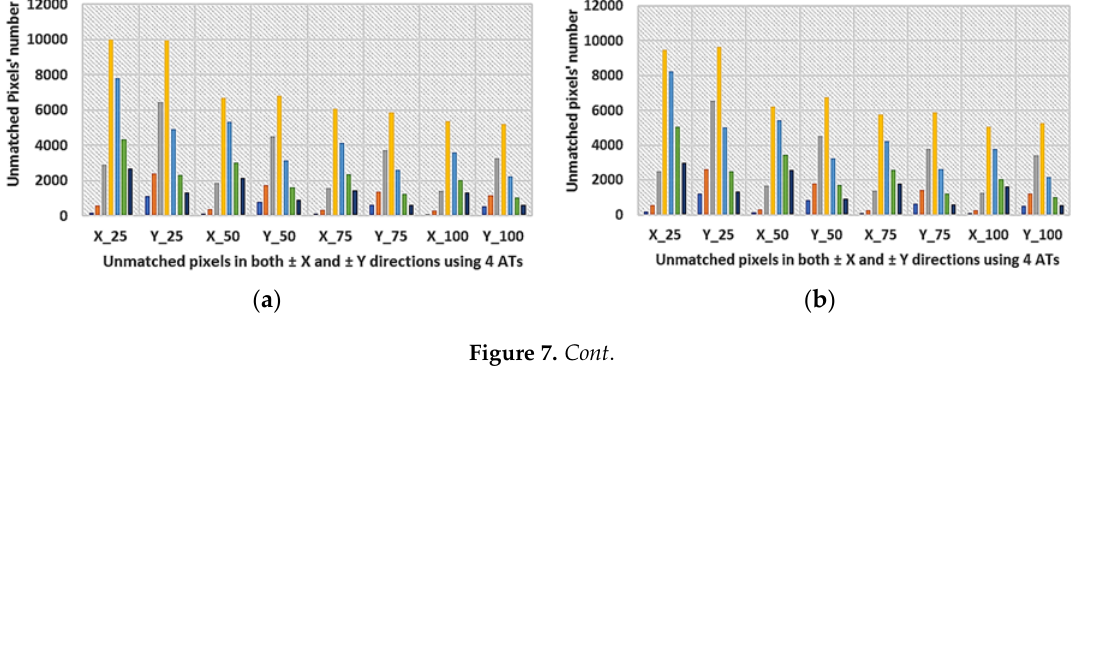
( h ) Figure 7. Deviations of channels’ pixels in in both ±X and ±Y directions at different ATs and PBTVs in a comparison between the networks extracted from both: (a) LiDAR DTM and SRTM 28.5 m, (b) LiDAR DSM and SRTM 28.5 m, (c) LiDAR DTM and ALOS DSM 28.5 m, (d) LiDAR DSM and ALOS DSM 28.5 m, ( e) LiDAR DTM and PALSAR DEM 28.5 m, (f) LiDAR DSM and PALSAR DEM 28.5 m, (g) LiDAR DTM and PALSAR DEM 12.5 m, and h. LiDAR DSM and PALSAR DEM 12.5 m. 5. Discussion 5.1. Vertical Accuracy of Global DEMs